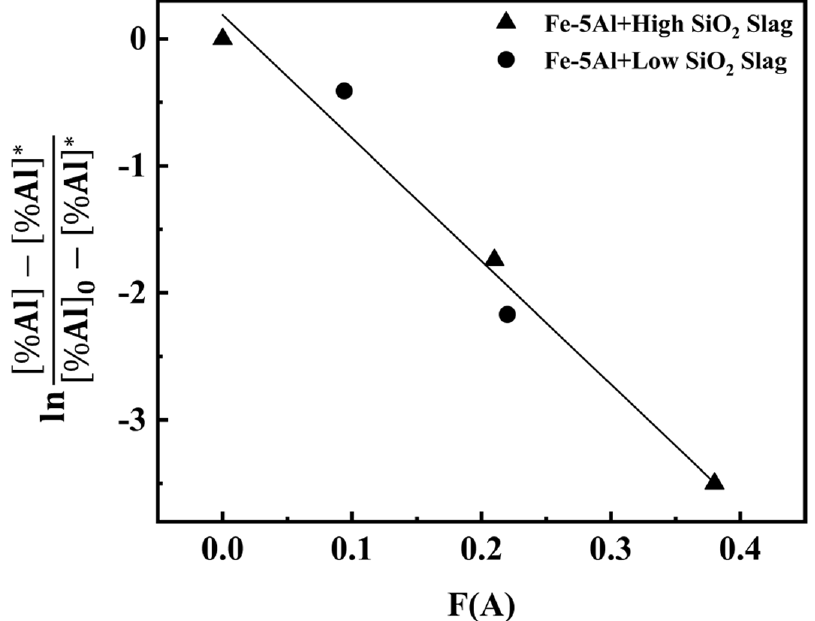
Figure 17. Relationship between interfacial area integral and logarithm of Al concentration during the reaction of Fe-5Al with CaO-SiO 2 -based slag.